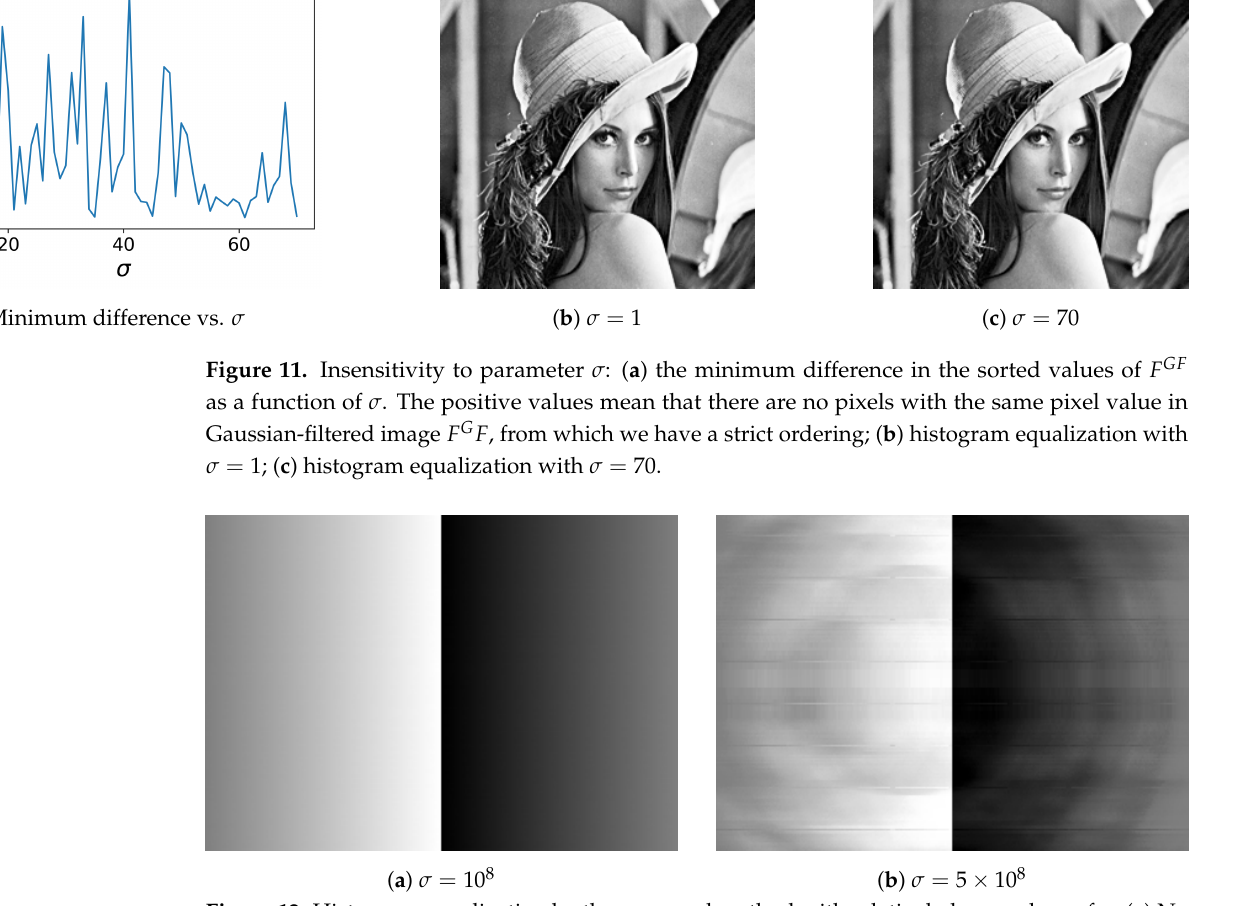
Figure 12. Histogram equalization by the proposed method with relatively large values of σ : ( a ) No artifact is generated with σ = 10 8 . ( b ) An artifact is generated with σ = 5 × 10 8 .